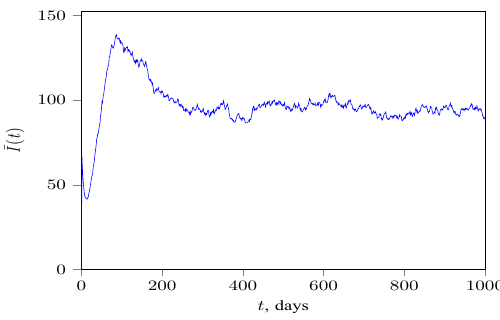
1 Figure 5. Dynamics of point estimates I ( t ) at experiment 1.